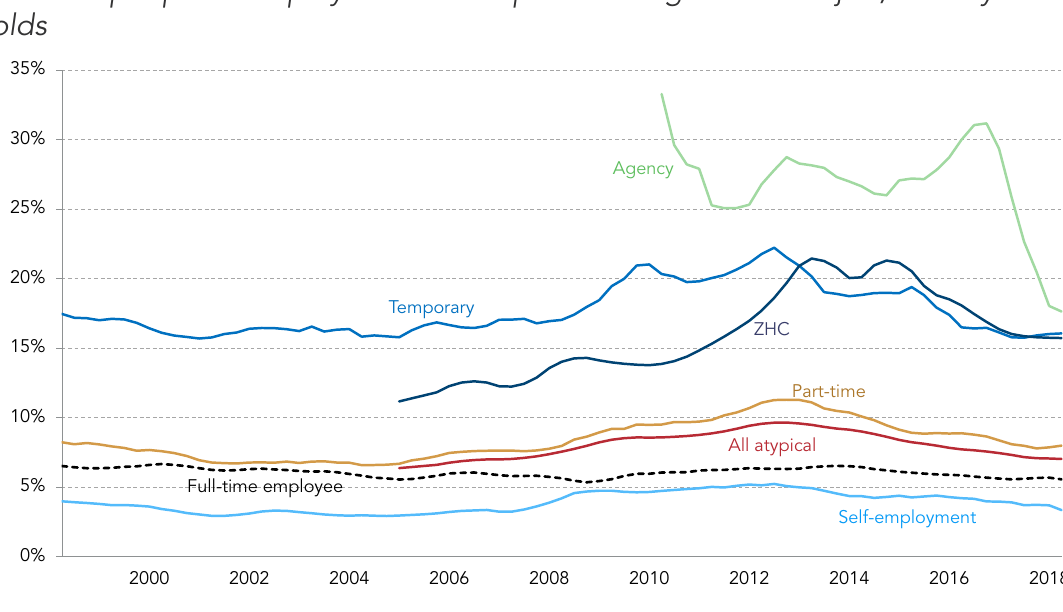
Figure 36: Atypical workers are more likely to want a different